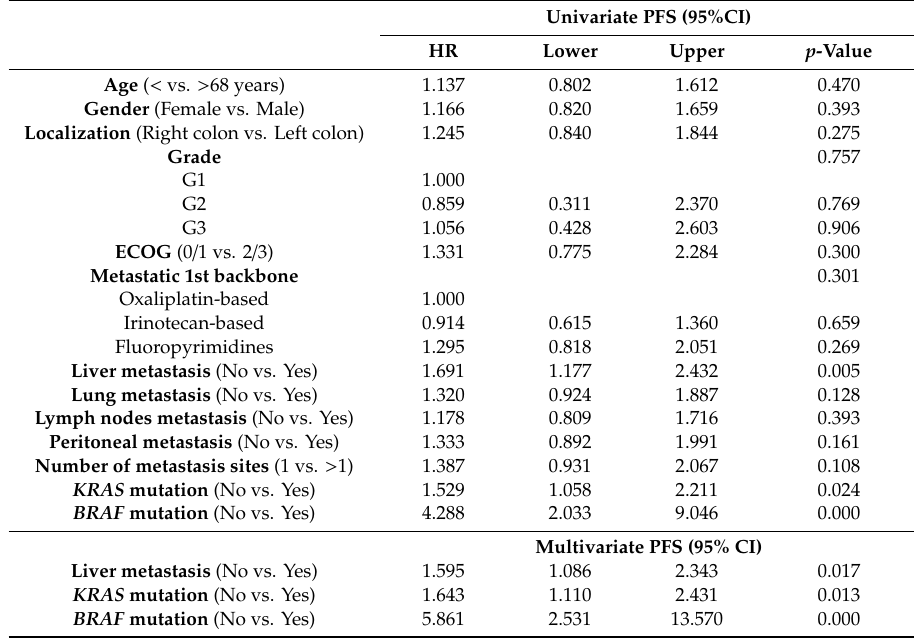
Table 3. Uni- and multivariate proportional hazard model of KRAS and BRAF, and other clinico-pathological variables in the progression-free survival of mCRC patients.